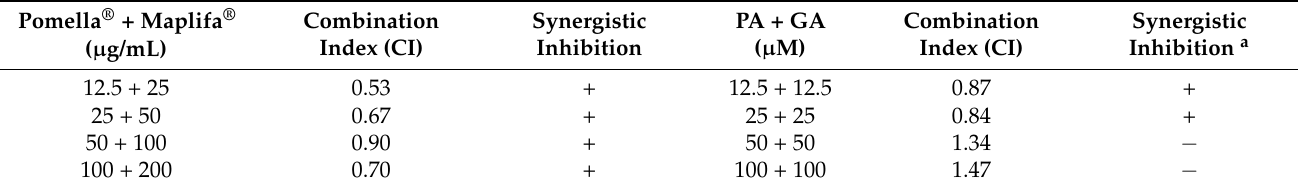
Table 1. CI values for the combinations of Pomella ® + Maplifa ® and PA + GA on the inhibition of collagenase